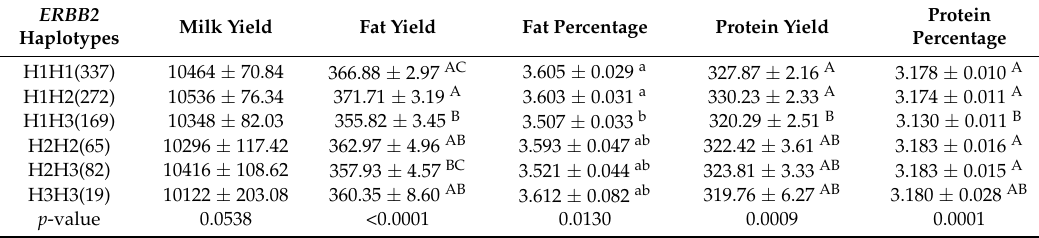
Table 5. Haplotype associations of the nine SNPs in ERBB2 with milk production traits in Chinese Holstein cattle (LSM ±